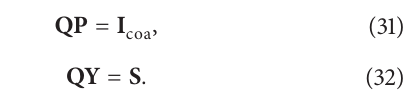
on the fine mesh to a grid on a the coarse mesh. We see